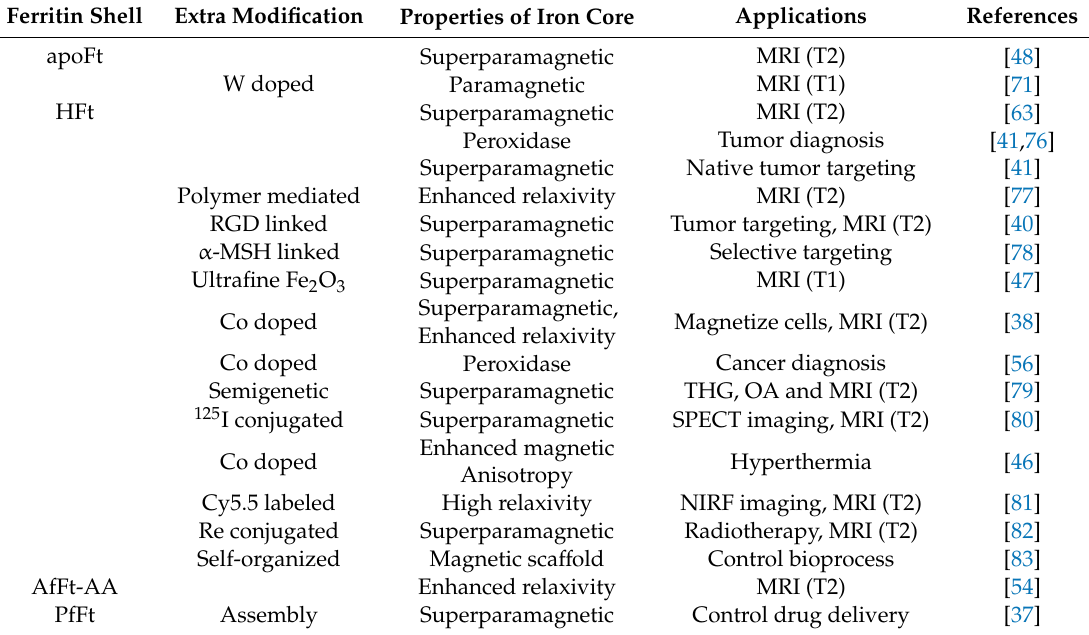
Table 1. Magnetoferritin in biomedical